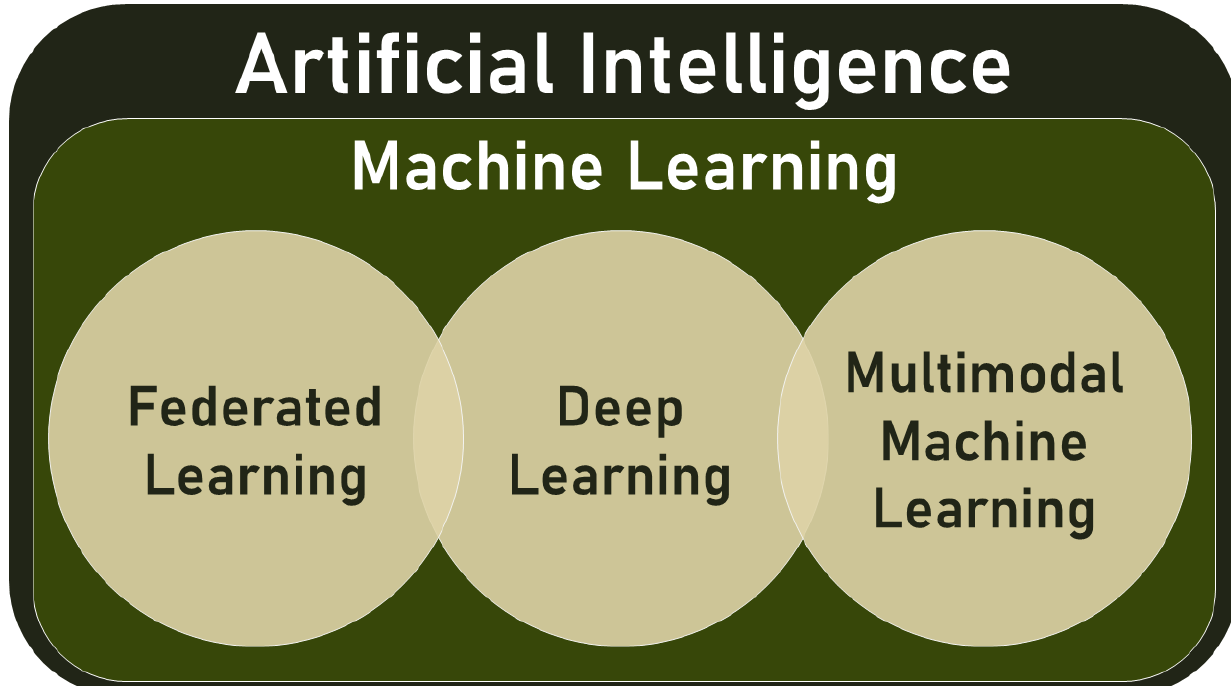
Figure 1. Artificial intelligence